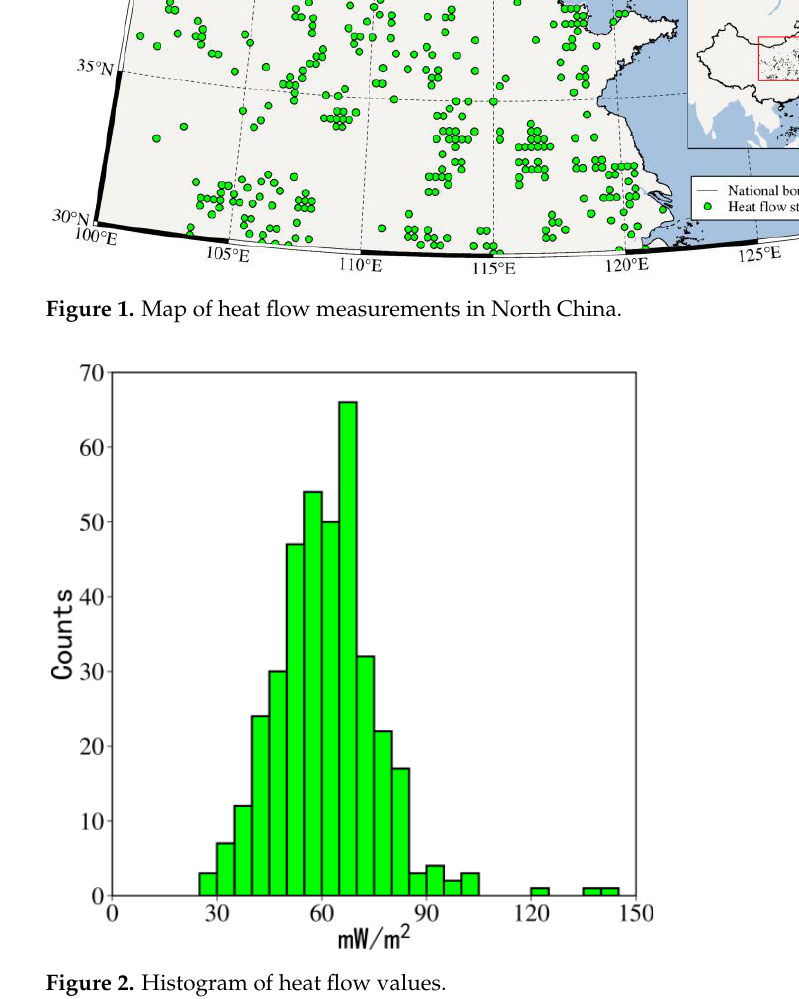
Figure 2. Histogram of heat flow values.